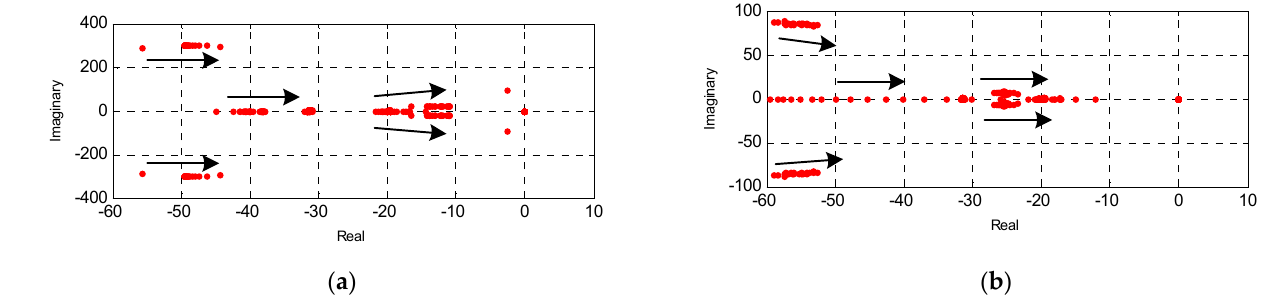
Figure 6. The system root locus diagram for the changes of D p and D q . ( a ) The root locus of the droop coefficient D p of the VSG changes from 0 to 500; ( b ) the root locus of the droop coefficient D q of the VSG changes from 0 to 1000.